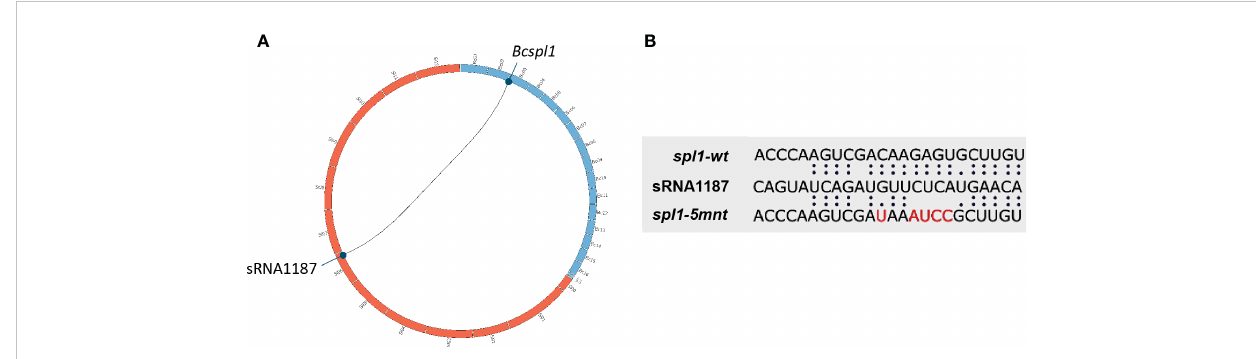
FIGURE 2 (A) Representation of the tomato genomic locus producing the sRNA1187 (tomato chromosomes presented as orange boxes) and the B . cinerea Bcspl1 locus ( B. cinerea chromosomes are presented as blue boxes). (B) Alignment of the sequences between tomato sRNA1187 and the wild type Bcspl1 transcript or the mutated version designed to abolish interaction with the